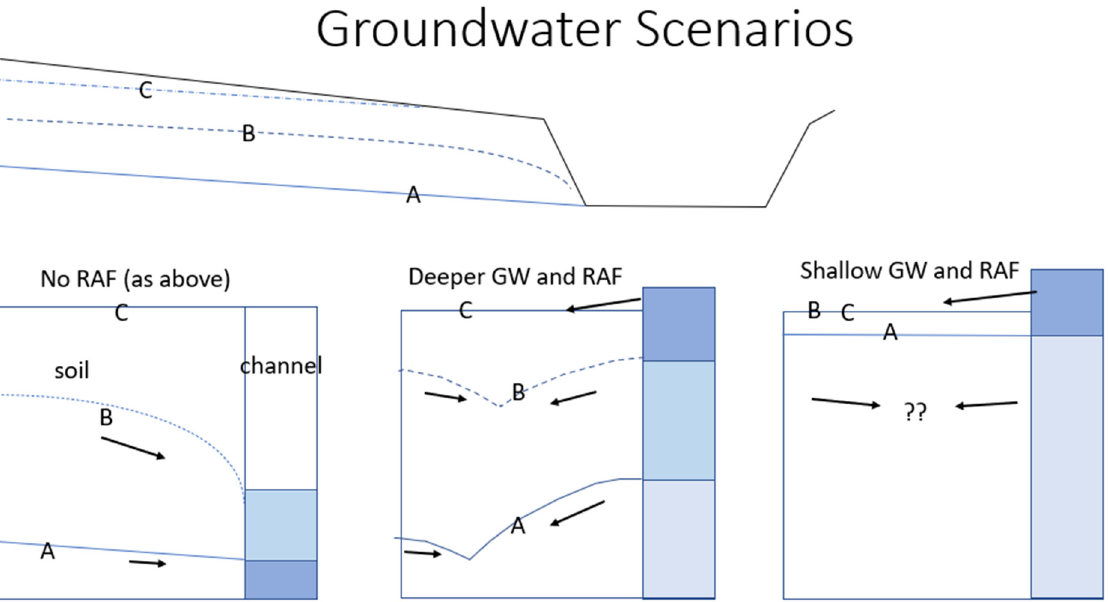
Figure 9. Groundwater (GW) dynamics and subsurface flow velocities for several scenarios: A is the groundwater position before the storm vent; B during the storm and C is when groundwater saturation is reached.